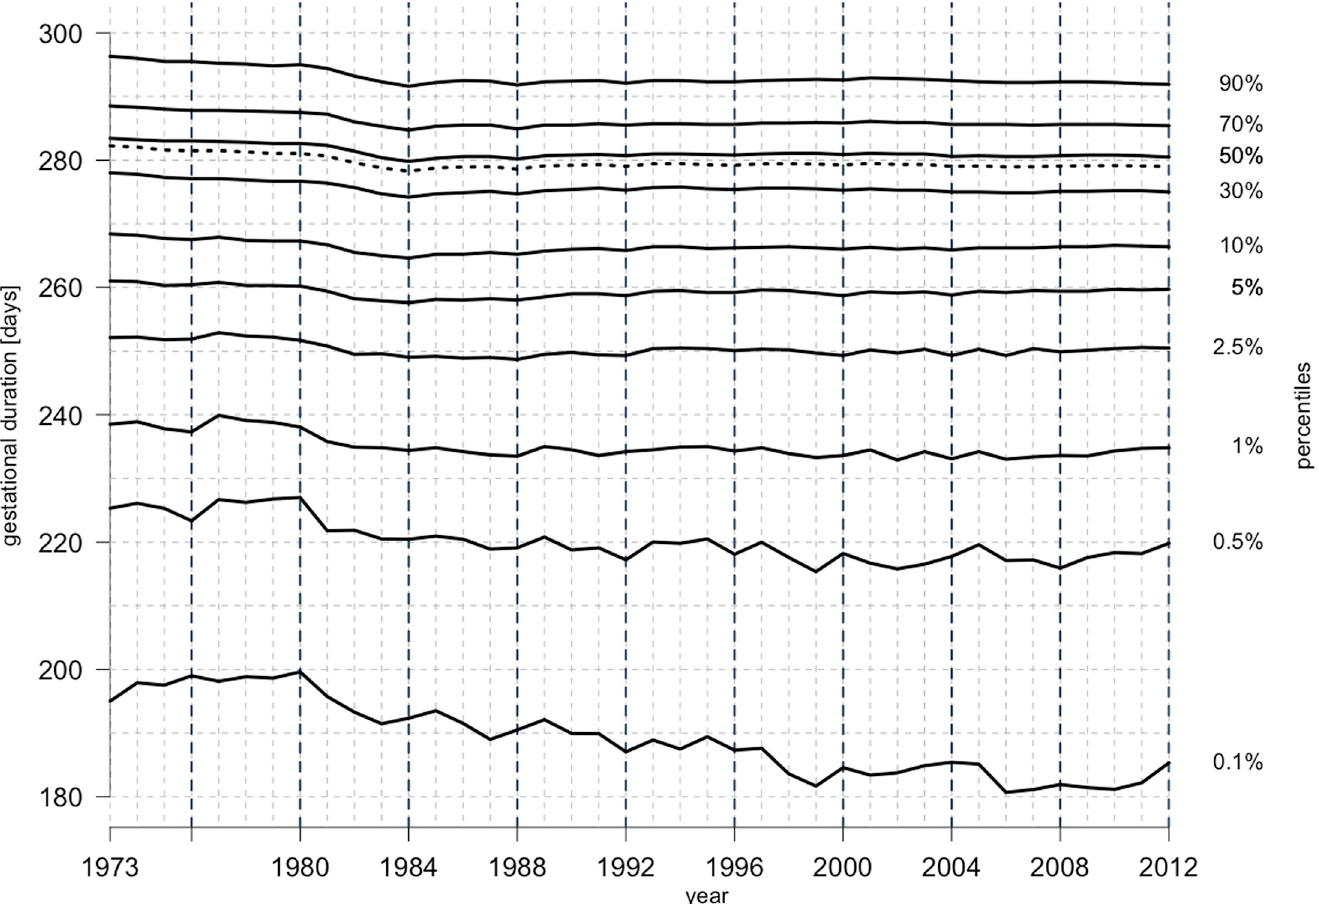
Fig 1. Pregnancy duration distribution, Swedish Medical Birth Register, 1973–2012. Gestational duration percentiles: 0.1 th , 0.5 th , 1 st , 2.5 th , 5 th , 10 th , 30 th , 50 th , 70 th , and 90 th ; percentiles are marked by solid lines. Dotted line represents mean gestational duration. The left-hand y-axis indicates pregnancy duration in days and the right-hand y-axis indicates percentiles. Vertical black dashed line indicates leap years. Sample size: n = 3 940 577.